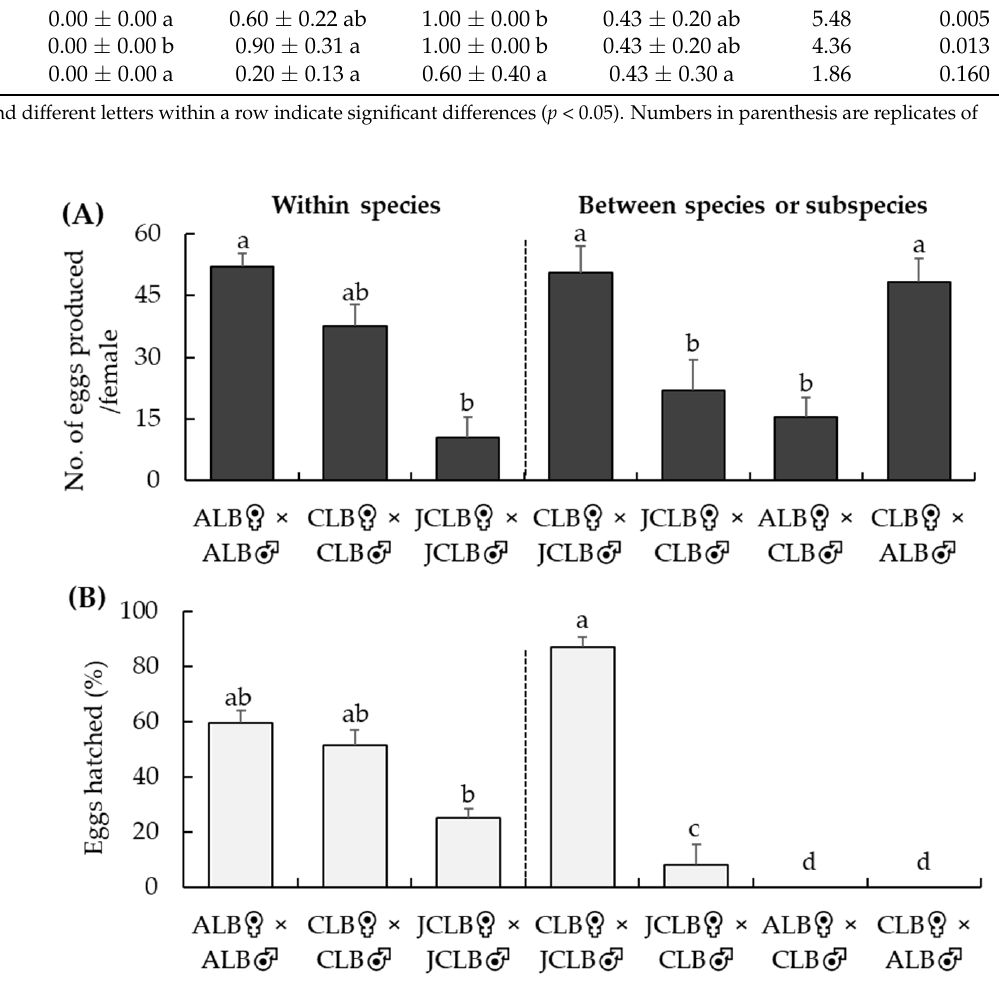
Figure 4. Crossing tests at NRSQL: numbers of eggs laid per female ( A ) Anoplophora glabripennis (ALB), A. chinensis (CLB) or A. malasiaca (JCLB) over a 4-week when paired with a conspecific or interspecific male and percentage of eggs hatched ( B ) in various crossing treatments. Bars refer to mean + SE and different letters above the bars indicate significant difference (ANOVA, p < 0.05). The hybrid offspring successfully developed from the CLB ♀ × JCLB ♂ and JCLB ♀ × CLB ♂ crosses were fertile. Over the four ‐ week exposure, F1 females of the CLB ♀ × JCLB ♂ hybrids produced 29.8 ± 6.8 eggs ( n = 13); 41.1 ± 11.1% of the eggs successfully hatched. One of the two tested F1 females from the JCLB ♀ × CLB ♂ hybrid female and CLB ♀ × JCLB ♂ hybrid male cross produced 34 eggs (79.1% eggs hatched) and one F1 female of the JCLB ♀ × CLB ♂ hybrids produced 2 eggs (both eggs hatched). 4. Discussion We demonstrated hybridization potential between these two invasive longhorned beetles of Asian origin (ALB and A. chinensis or A. malasiaca ) under the laboratory condi ‐ tions. A short period of behavioral observations of paired adults, followed with a four ‐ week exposure of the female to host bolts, showed that ALB female did not mate with A. chinensis male. Although mating occurred between A. chinensis female and ALB male, the female did not produce any viable eggs. However, female ALB and A. malasiaca male mated successfully to produce viable F1 offspring, while A. malasiaca female and ALB male did not mate. Anoplophora chinensis and A. malasiaca could mate (either direction) to produce fertile offspring. It is not surprising that these two species appeared to recognize each another as po ‐ tential mates because they share some similar pheromones and mate ‐ finding behaviors as well as mating periods and genitalia [10,28–31]. However, our results showed that A. chinensis and A. malasiaca differed in terms of the male’s response towards ALB females possibly due to a difference in female contact pheromone composition or other courtship signals that lead to mate recognition. Anoplophora chinensis males ignored ALB females and many of them flew away, possibly indicating that the male did not recognize the fe ‐ male, while A. malasiaca males mated with ALB females successfully. Our results showed that ALB males approached A. chinensis females, and most males mounted and attempted copulation. In contrast, ALB males did not mate with A. malasiaca females. This shows not only an asymmetrical hybridization between ALB and A. malasiaca , but also differences in